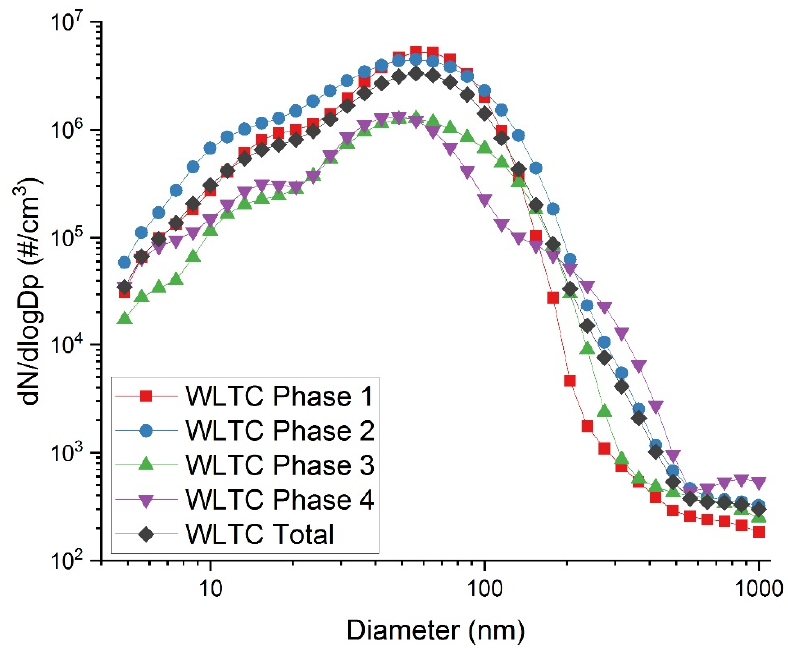
Figure 9. WLTC total and phased average PNSD.